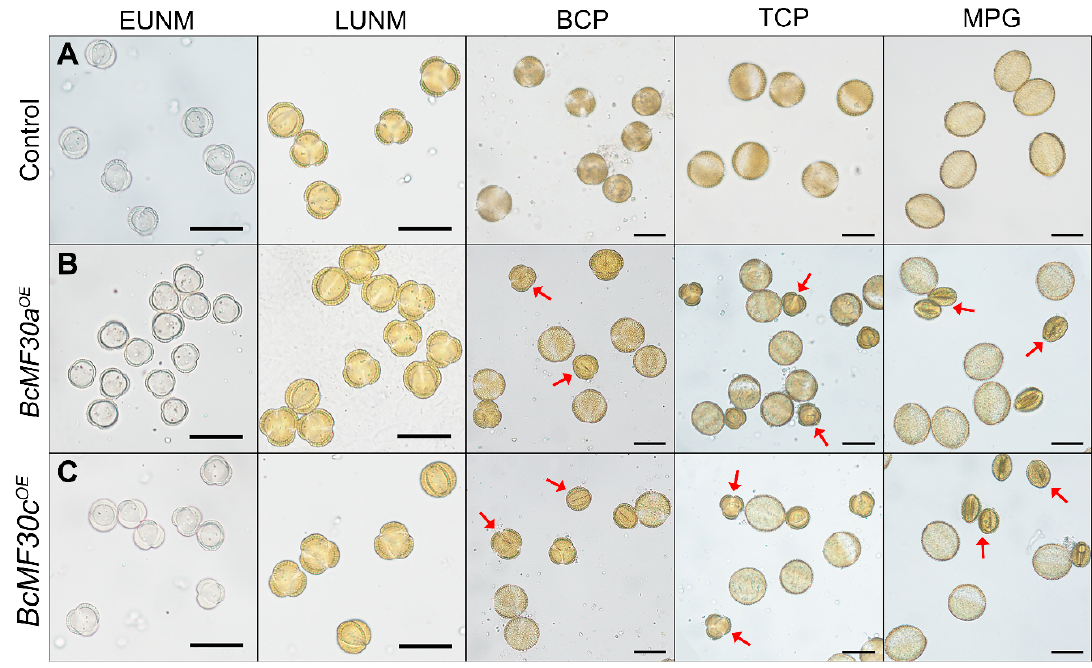
Figure 3. The pollen grains produced by BcMF30a OE and BcMF30c OE transgenic plants at different developmental stages were observed by optical electron microscope. Pollen grains produced by the